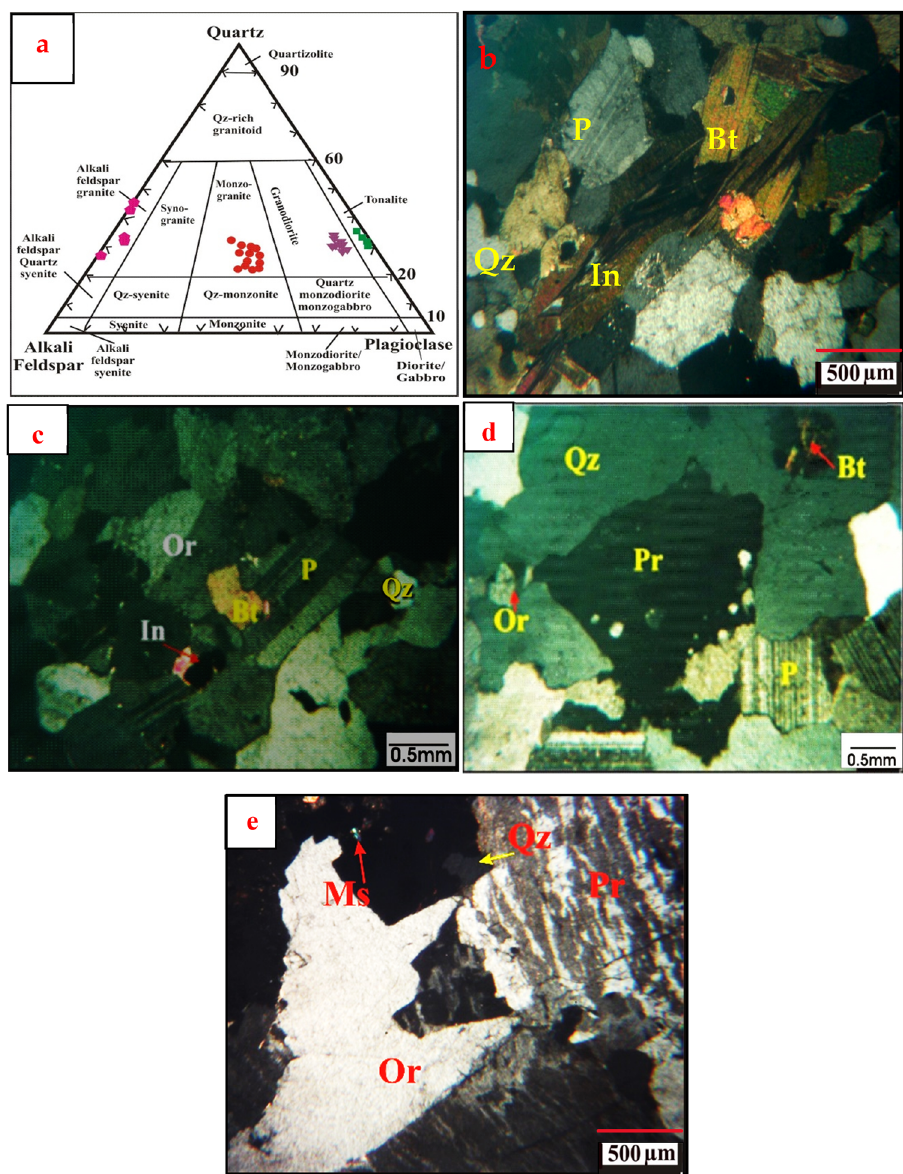
Figure 4: ( a ) Plots of the investigated granites on QAP diagram [ 29 ] and ( b ) photomicrograph showing fl aky crystals of biotite ( Bt ) associated with plagioclase ( P ) and quartz grains ( Qz ) in tonalite. ( c ) photomicrographs showing albite twin of plagioclase ( P ) associated with quartz grains ( Qz ) and crystal of orthoclase ( Or ) in granodiorite, ( d ) subhedral crystal of perthite ( Pr ) enclosing grains of quartz ( Qz ) to show poikilitic texture with very fi ne grain of biotite ( Bt ) and twin of plagioclase ( P ) in monzogranite and ( e ) orthoclase perthite ( Or ) with grains of quartz ( Qz ) and very fi ne grained of muscovite ( Ms ) in the alkali feldspar granite ( CN ) .